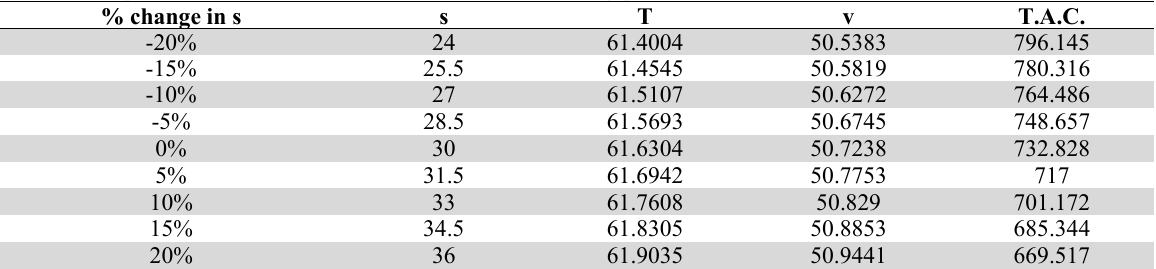
Effect on optimal solution for distinct values of selling price (s)